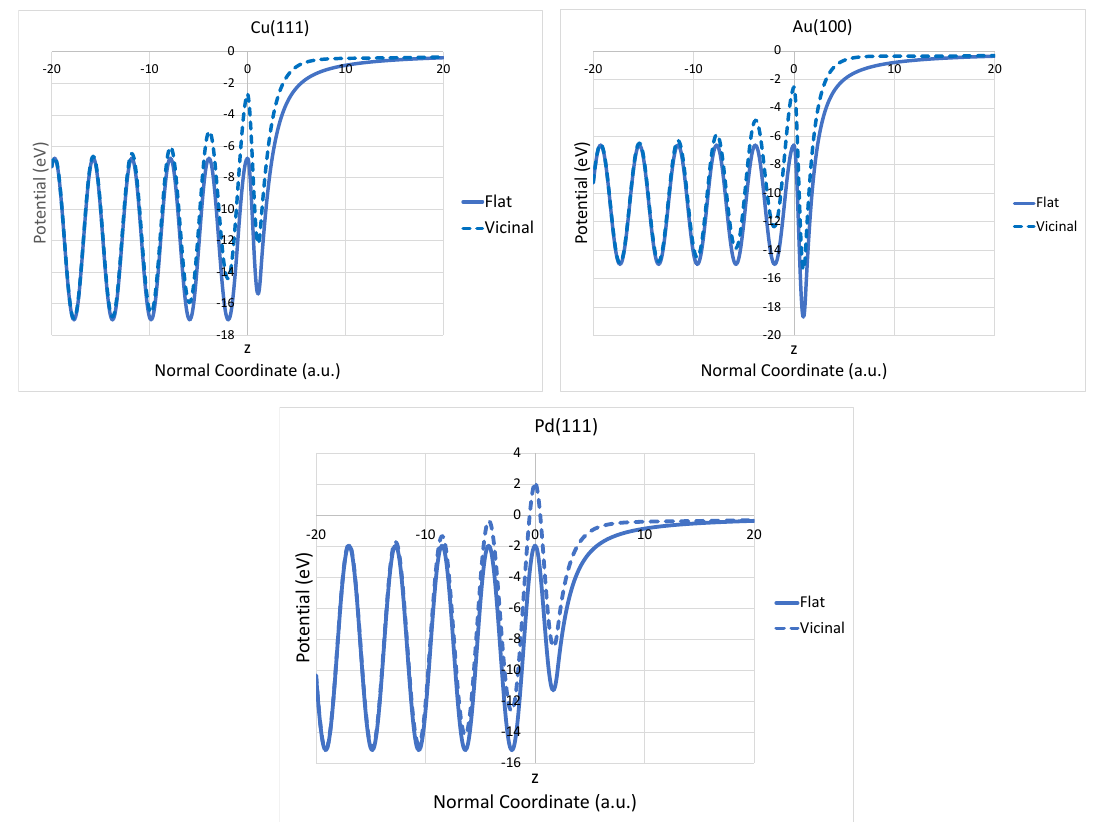
Figure 2. The potentials in one-dimension for the metals Cu(111) ( top left ), Au(100) ( top right ) and Pd(111) ( bottom ). The solid lines are the one-dimensional ( z ) parametric potentials of the flat surface [32], while the dashed lines show the addition of the potential, as in Figure 1, in the vicinal direction at one of its peaks, scaled by a factor of 2.8 and duly attenuated (see text). The dashed curve for Pd(111) is a z -section of Figure